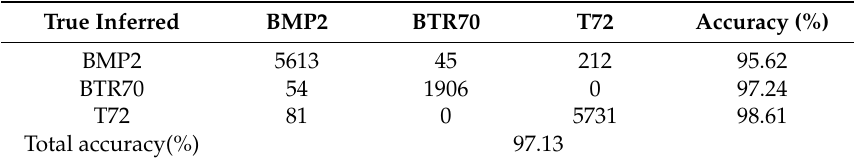
Table 2. Confusion matrix of the best model ( L = 15) for three targets